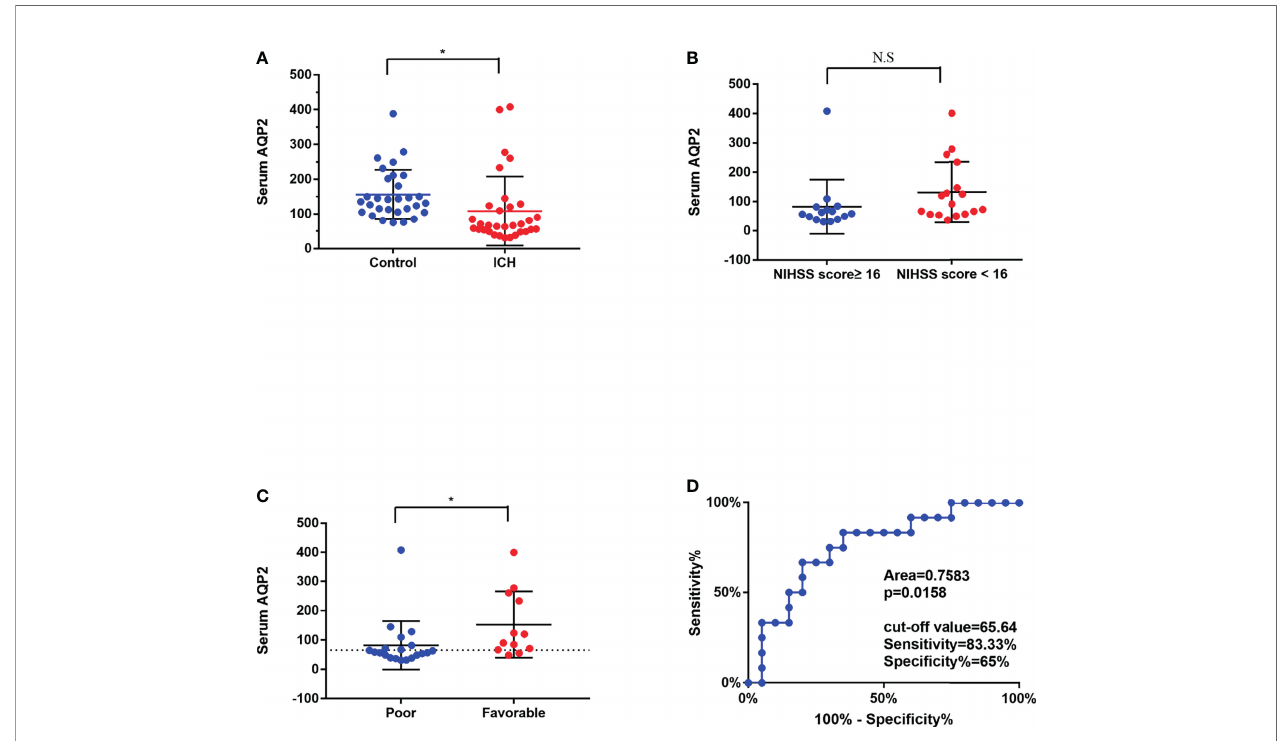
FIGURE 1 | Mean serum AQP2 concentrations in different groups. (A) Serum AQP2 concentration had signi fi cantly decreased at 1 days after the bleeding in an ICH patient compared to that in a healthy control (*P < 0.05). (B) Mean serum AQP2 concentrations was presented no difference between patients with NIHSS scores ≥ 16 and NIHSS scores < 16. (C) Mean serum AQP2 concentrations in poor prognosis (mRS scores>3) were signi fi cantly lower in comparison to those in favorable prognosis (mRS scores ≤ 3) (*P < 0.05). (D) ROC curves of serum AQP2 concentrations for predicting different